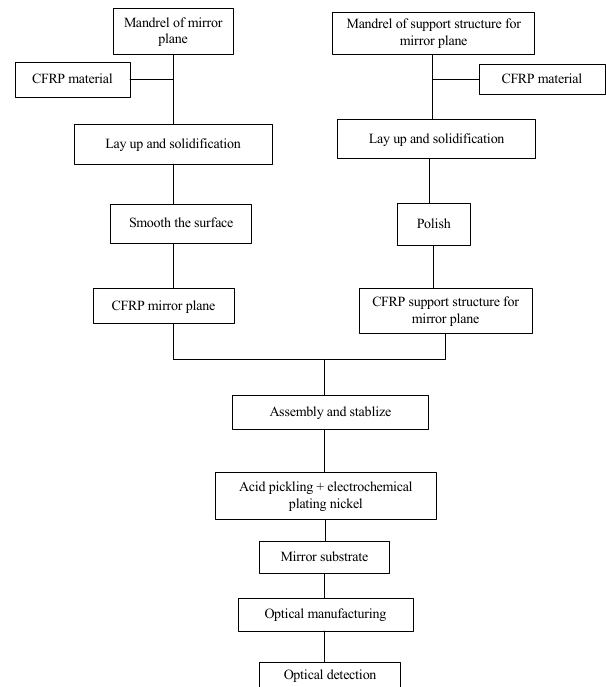
Fig. 2 Preparation processes of the CFRP